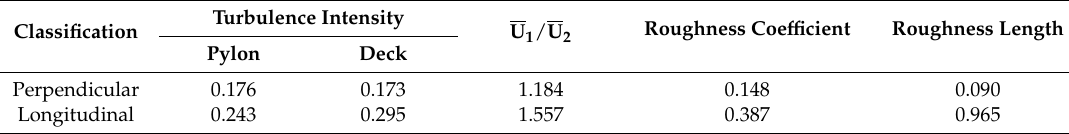
Table 3. Turbulence intensity, roughness coe ffi cient, and length.